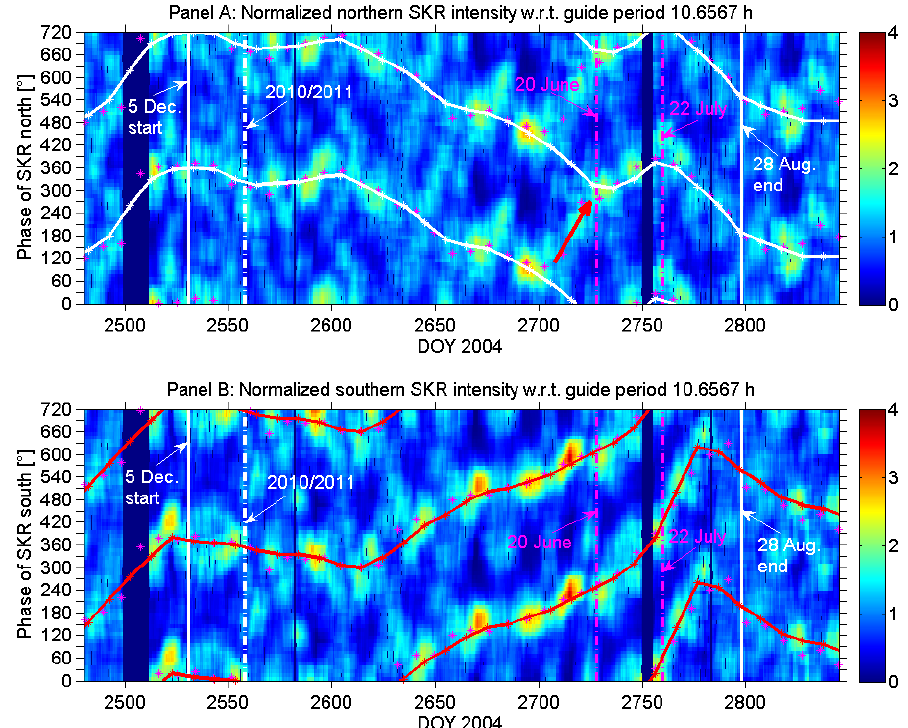
Figure 5. Phase drift of northern and southern SKR with respect to a constant guide period of 10.6567h around the GWS event. We show the time interval from day 2480 to 2845 which lasts 1 year starting on 15 October 2010. The SKR intensities are averaged for guide phase intervals of 10 ◦ (corresponding to ∼ 18 min), and they are plotted over two rotations (720 ◦ ). The intensities (north and south) are normalized by dividing them by the averaged SKR intensity over one rotation, and this ratio r is color-coded according to the color bar on the right side. To enhance the visibility of the SKR maxima, the whole 2-D matrix of SKR intensity ratios ( r as a function of time and phase) was smoothed by replacing each value r of the intensity ratio by the mean over a rectangle of 70 ◦ and 17 rotations centered on r . The white and red lines trace the northern and southern SKR maximum values, respectively. The vertical white lines mark the start of the lightning activity related to the GWS event on 5 December 2010, and the last day with lightning activity on 28 August 2011. The dash-dotted vertical magenta lines inside those boundaries are placed on 20 June and 22 July 2011. Those dates are related to pronounced changes in lightning activity which is described in more detail in the text. The red arrow in (a) is also discussed in the text. The white dash-dotted line indicates the turn of the year 2010/2011. The magenta stars were calculated with directional statistics (see Appendix C of Fischer et al., 2014) to help tracing the SKR